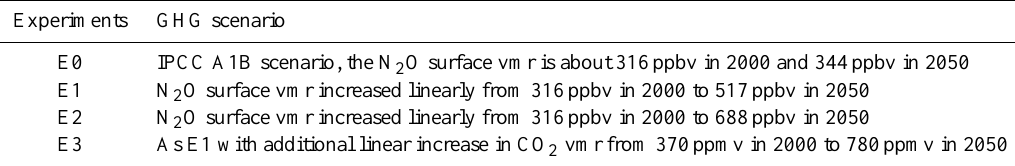
Table 1. The configurations of four CCM transient simulations.